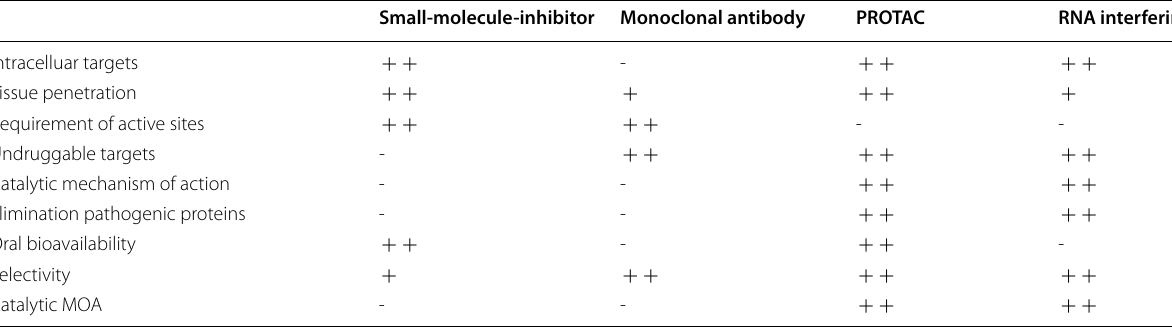
“ ” represents “Yes”, “ ” represents “Poor”, “-” represents “No”